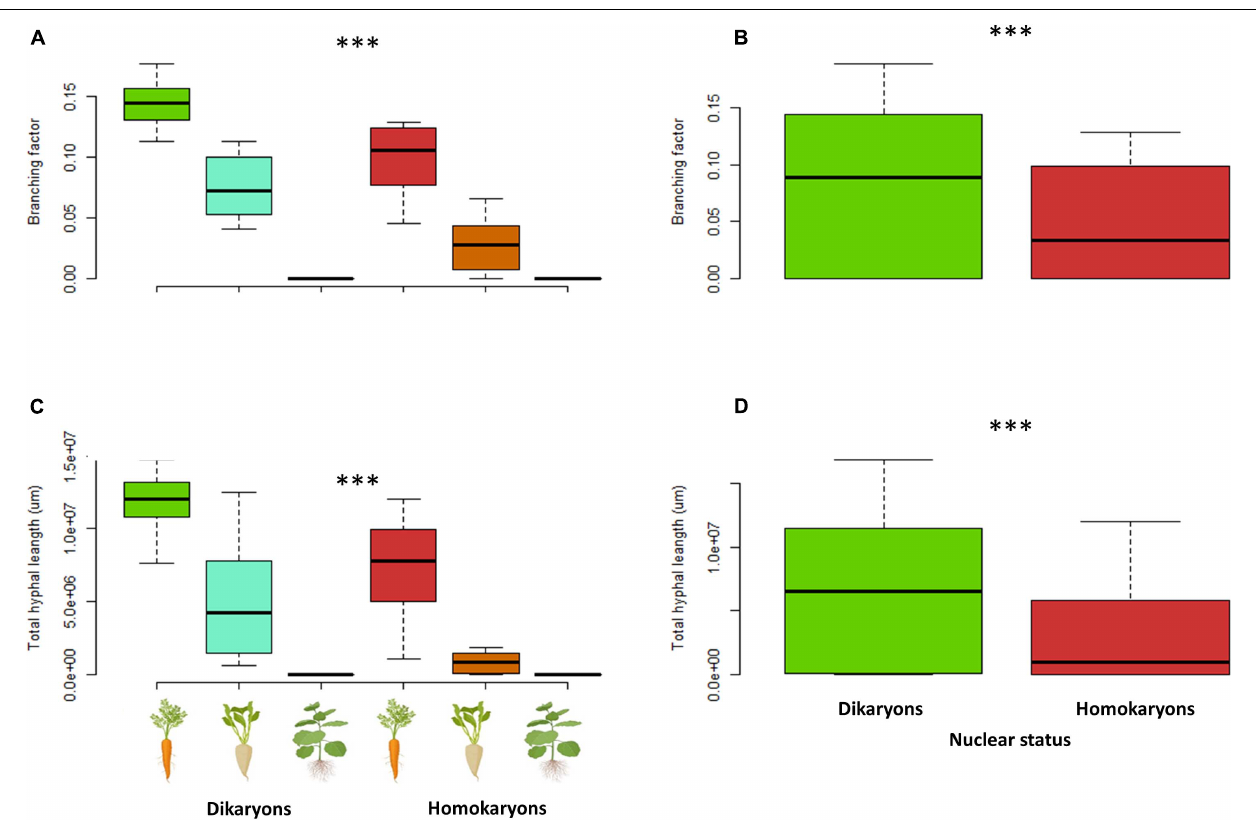
FIGURE 7 | Branching factor (A,B) and total hyphal length (C,D) between four dikaryotic and four homokaryotic strains of Rhizophagus irregularis per root organ culture host used in the study. (A,C) Trait variation per nuclear status and host plant identity. (B,D) Trait variation per nuclear status. ∗∗∗ indicates statistical significance at <